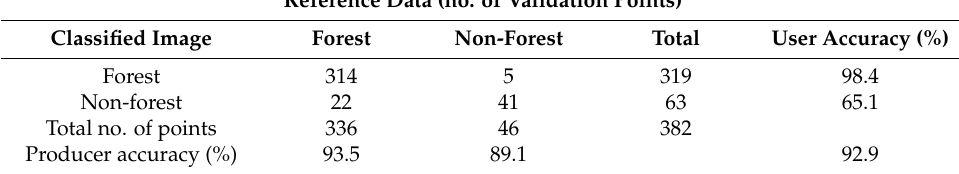
Table 4. Error matrix for classification of the forest and non-forest land cover types. The 382 validation points were